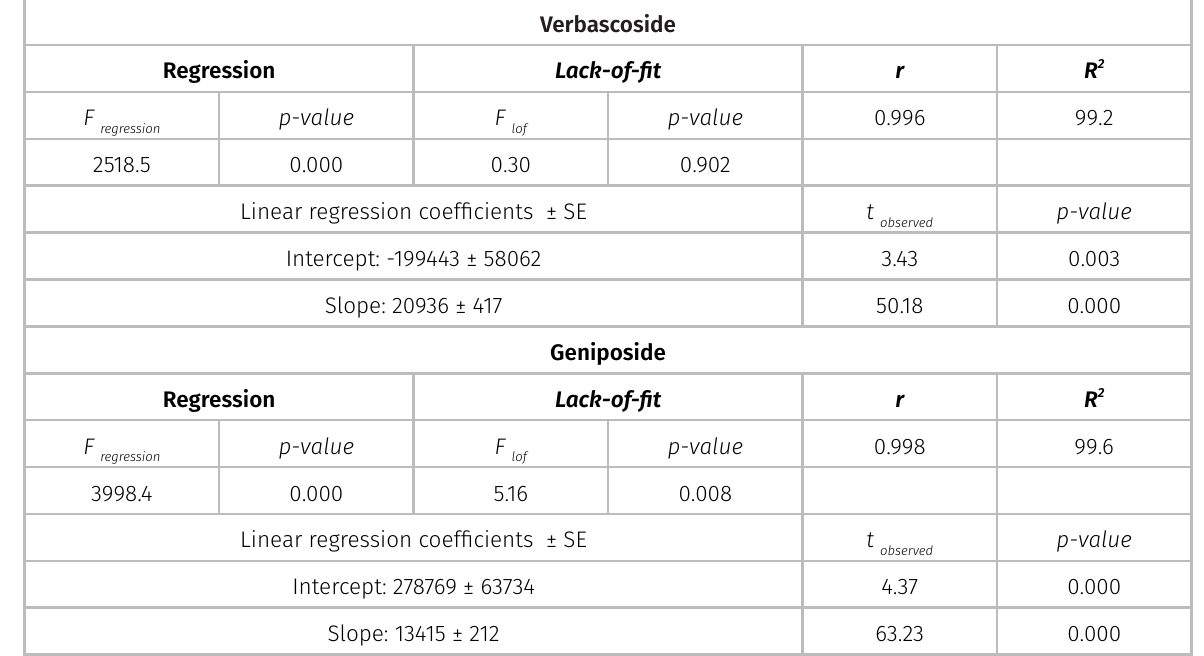
Table I. Linear regression parameters for quantitation of Verbascoside (phenylpropanoids) and Geniposide (iridoids) by HPLC-DAD.